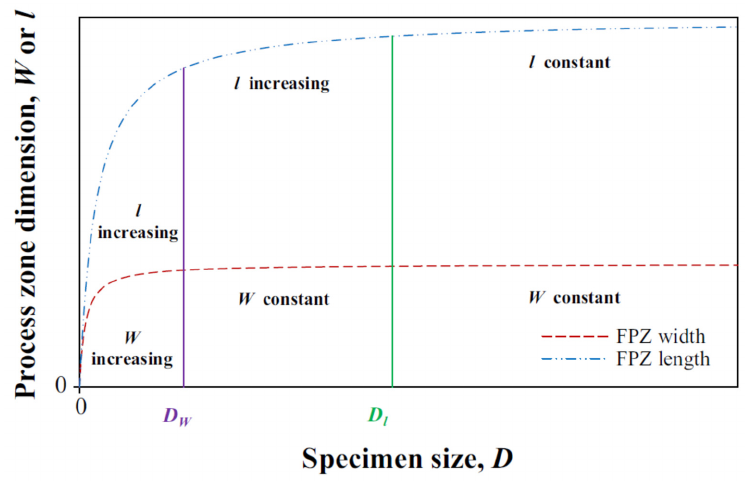
Figure 9. The concept map of the effect of specimen size on the dimensions of the FPZ. Reprinted with permission from Ref. [173]. Copyright 2017, Springer Nature.